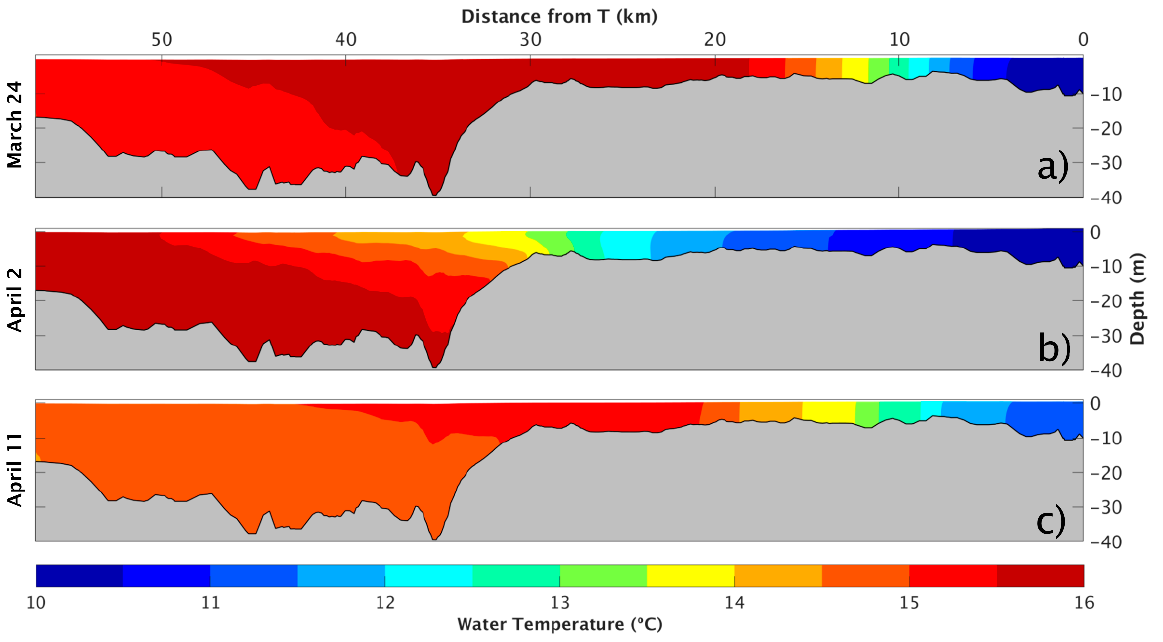
Figure 5. Daily averaged vertical profiles of water temperature along the longitudinal section to the estuary (#ScRef); ( a ) 24 March; ( b ) 2 April; ( c ) 11 April, before, during, and after the extreme freshwater discharge event, respectively.